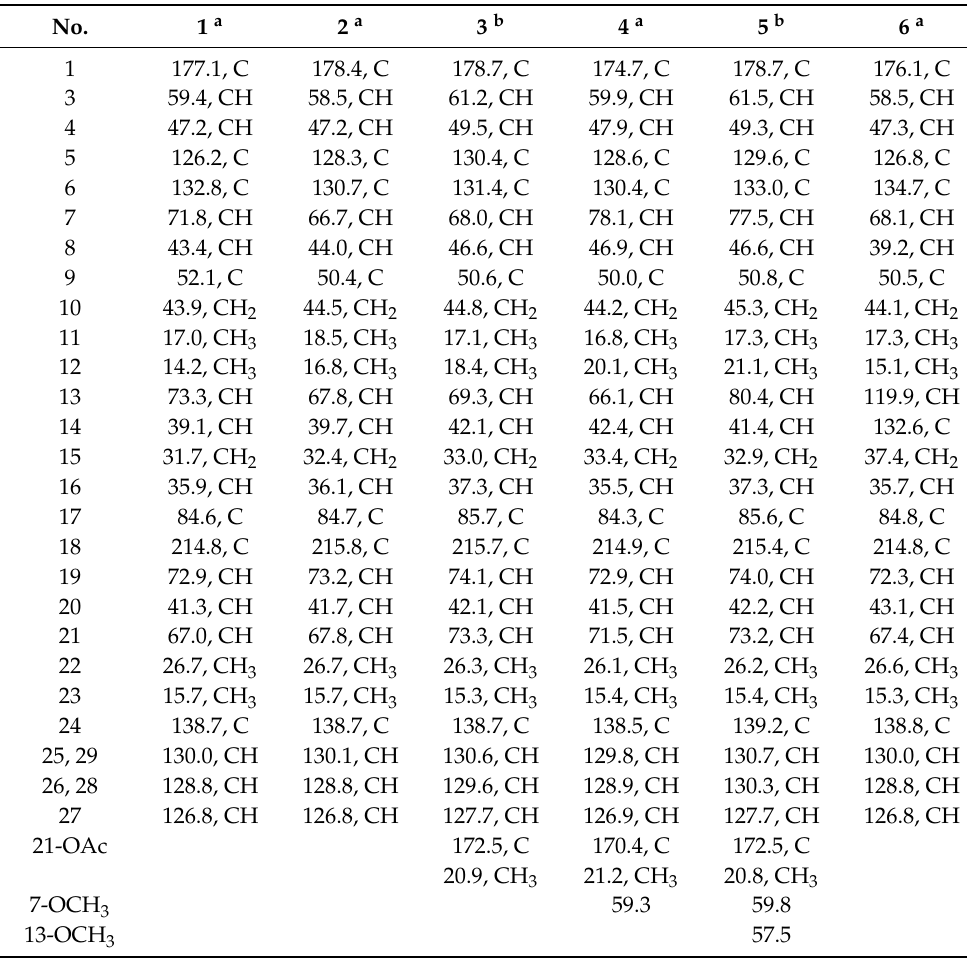
H-3 to C-1 and C-9, H-11 to C-4, C-5 and C-6, H-8 to C-4, and C-6 and C-9, the fusing pattern of rings A and B can be determined. In addition, the rings B and C of 1 were suggested to be fused through C-9 and C-8 based on the HMBC correlations between H-20 and C-9, between H-21 and C-4, and between H-13 and C-7. Locations of the acetyl group ( δ C 214.8 and 26.7) at C-17 ( δ C 84.6) and the phenyl group at C-10 in 1 were determined by HMBC correlations from CH 3 -22 to C-17 and C-18, and from H-10 to C-24 and C-25/29. Table 1. The 13 C NMR data (150 MHz) of compounds 1 – 6